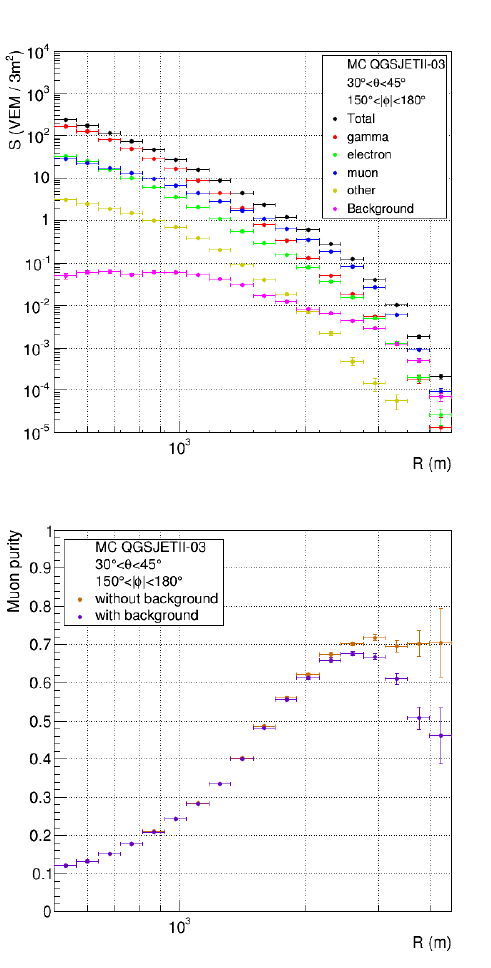
Figure 9. (Top) Data-MC comparison of signal size as a function of R . (bottom) Data / MC ratio of the signal size. Statistical un- certainties are shown as thick lines while total errors are in gray lines. (Figure from [6])